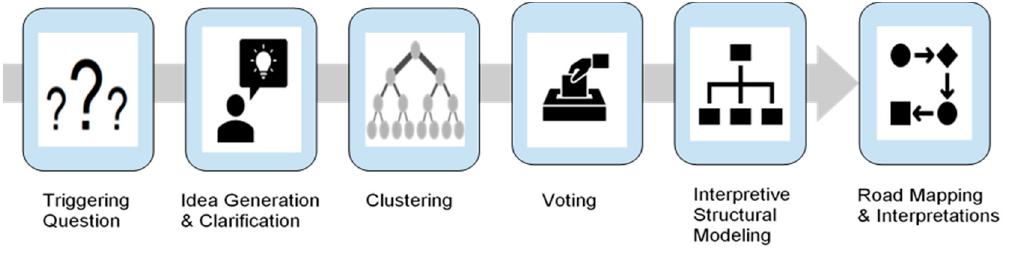
Figure 1. The implementation of the structured democratic dialogue (SDD) process.